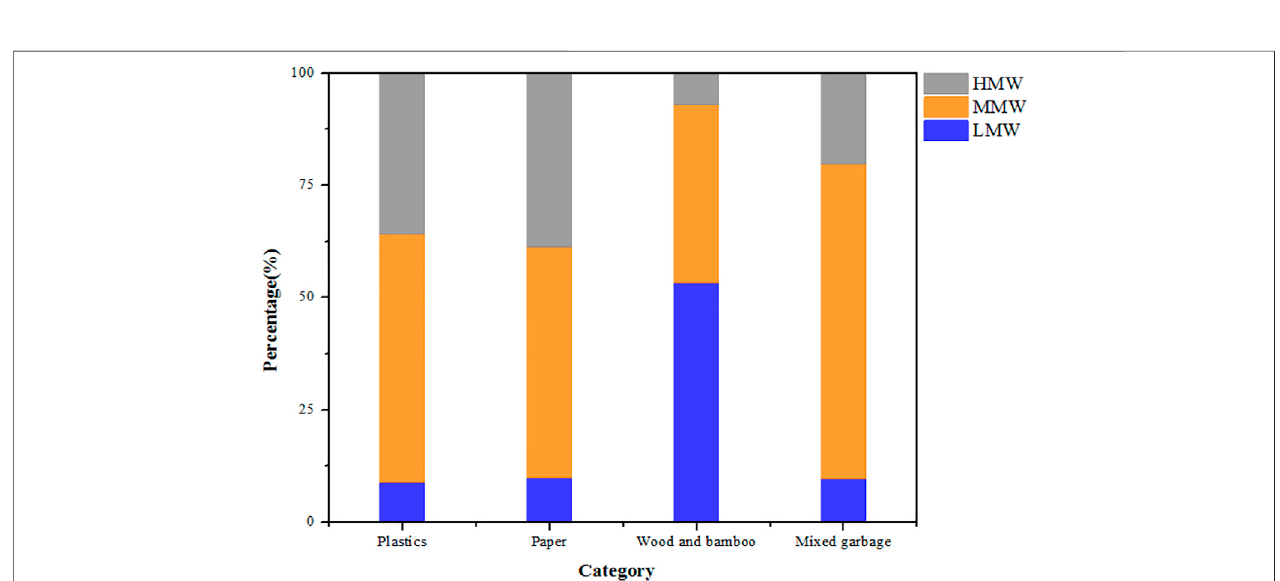
FIGURE 3 | The ratio of LMW, HMW, MMW of PAHs in different waste components during open burning.